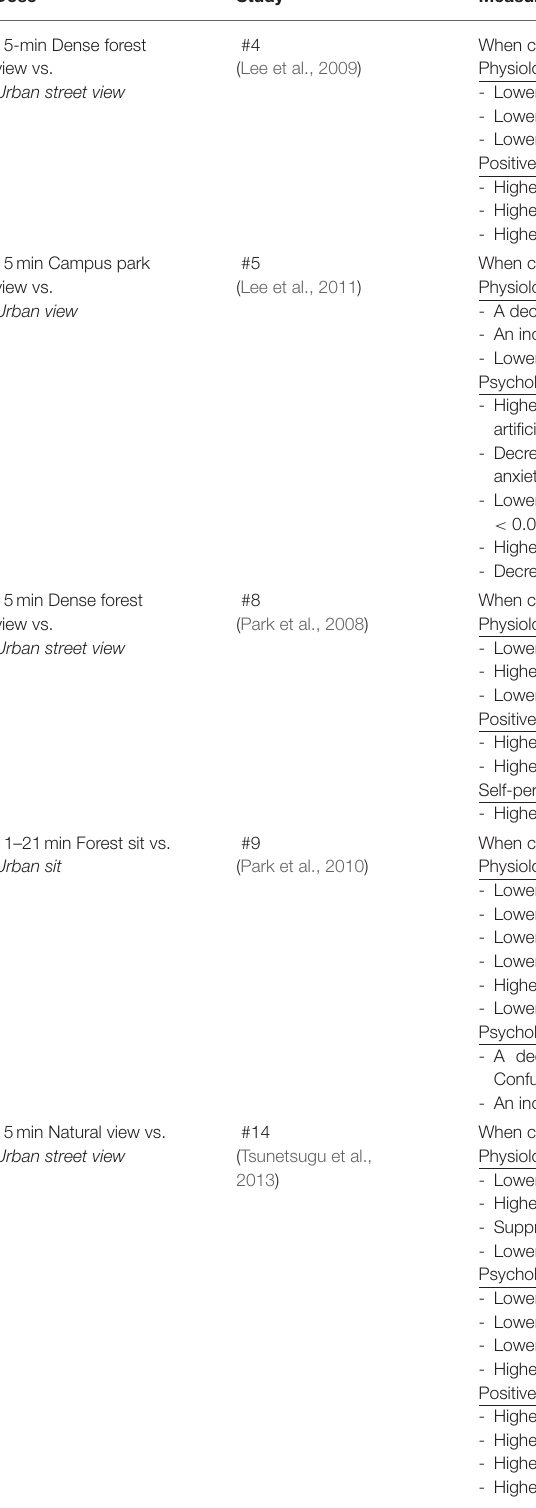
TABLE 3 | Measured effects of time in nature via included studies 10–30min of sitting outdoors: natural vs. urban view. Dose Study Measured effect (from natural setting when compared to urban setting ) 15-min Dense forest view